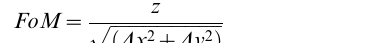
z FoM ~ p ð 2 Þ ffiffiffiffiffiffiffiffiffiffiffiffiffiffiffiffiffiffiffiffiffiffiffiffi D x 2 z D y 2 ð Þ